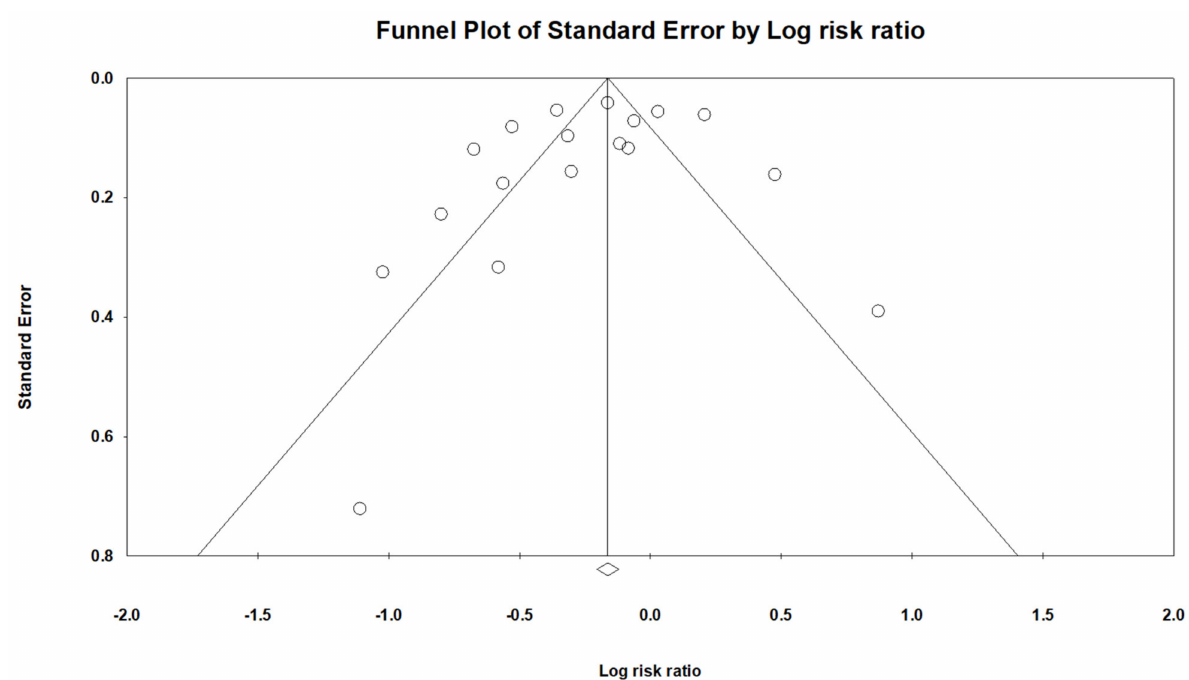
Figure 3. Funnel plot for the detection of possible bias of publication on the effect of statin use on PD